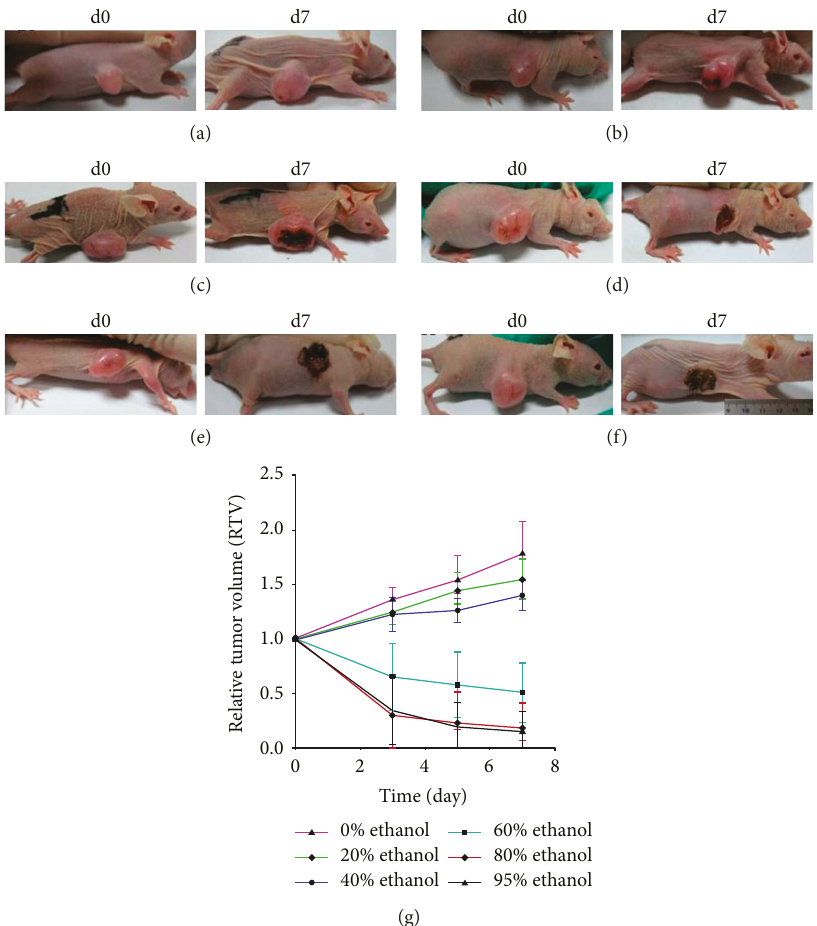
Figure 1: E ff ect of ethanol injection on the subcutaneous pancreatic cancer cell mouse xenograft model. The tumor volume and relative tumor volume (RTV) of these mouse xenografts signi fi cantly changed after di ff erent doses of ethanol were injected into the tumor xenografts of nude mice ((a) 0%, (b) 20%, (c) 40%, (d) 60%, (e) 80%, and (f) 95%). (g) Summary of the